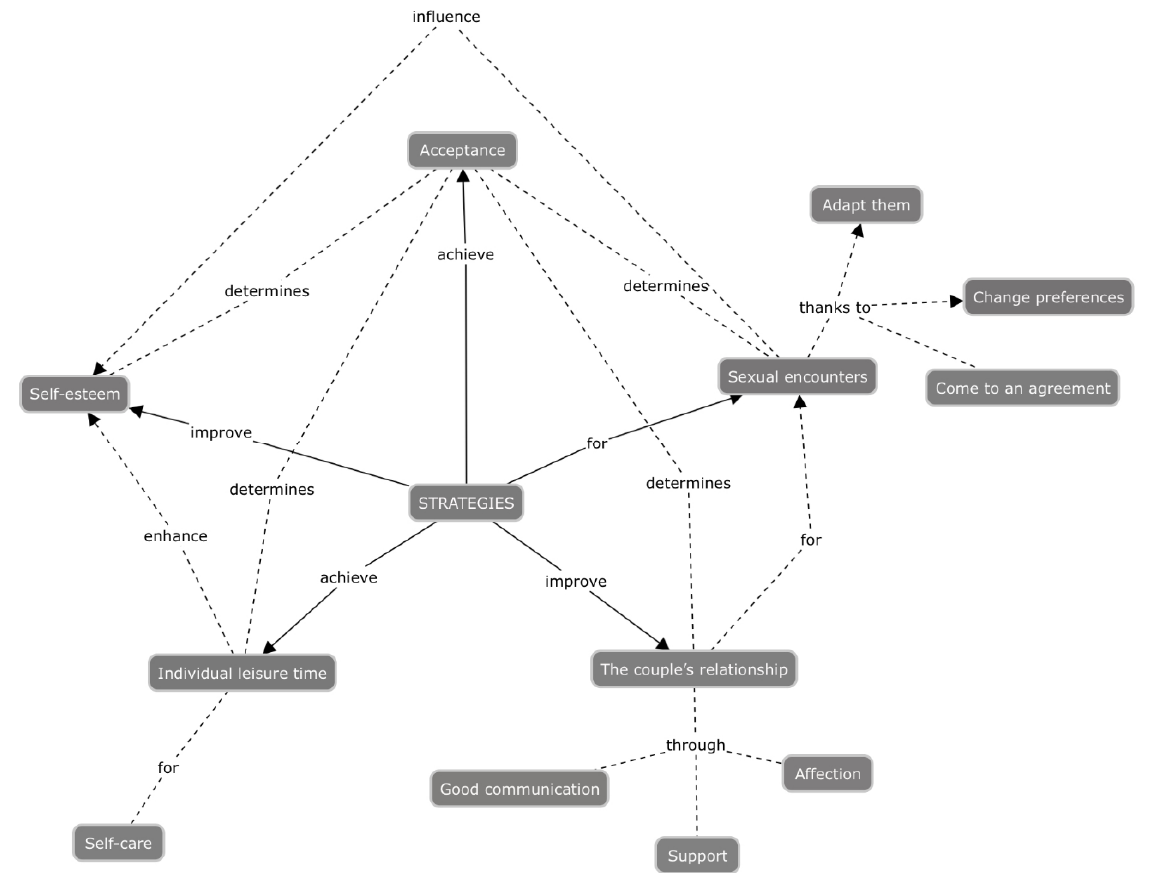
Figure 1. Network of strategies adopted in sexual relations by women in the first 6 months postpar- tum period.